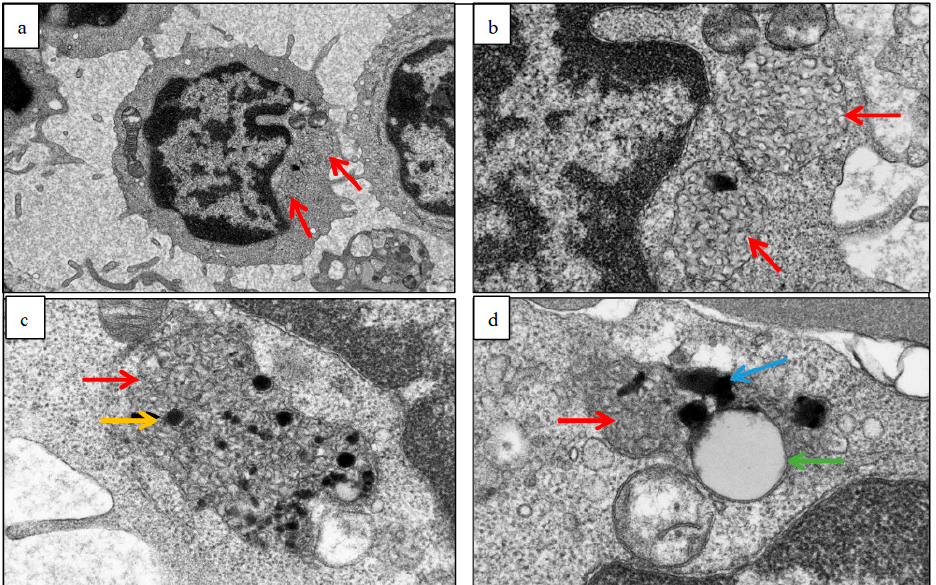
Figure 1. Electron micrographs of peripheral blood buffy coats pre- and post-treatment in patient E: ( a , b ) show low- and high-power images (mag. ×3,000 and mag. ×10,000), respectively. These demonstrate clusters of membrane-bound, regularly arranged curvilinear inclusions (red arrow), typical of CLN2 disease, taken prior to treatment initiation (pre-ERT). ( c ) shows a high-power image (mag. ×12,000) one year post-ERT. There are irregular curvilinear-like inclusions (red arrow) with electron dense material representing fragments. There is also a fingerprint stack (yellow arrow) which is seen occasionally in CLN2 lymphocytes. ( d ) shows a high-power image (mag. ×15,000) two years post-ERT. There are poorly defined curvilinear-like storage inclusions (red arrow) with prominent lipid droplets (green arrow) and electron dense debris (blue arrow) (mag. ×15,000).